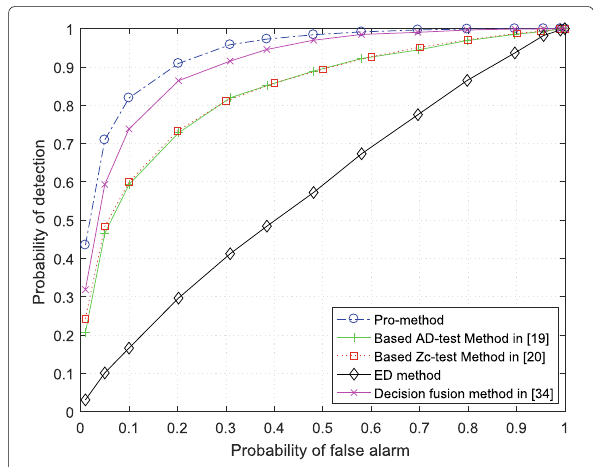
Fig. 8 ROC curves comparison among different spectrum sensing methods with Q = 8, K = 20 at SNR = − 15 dB